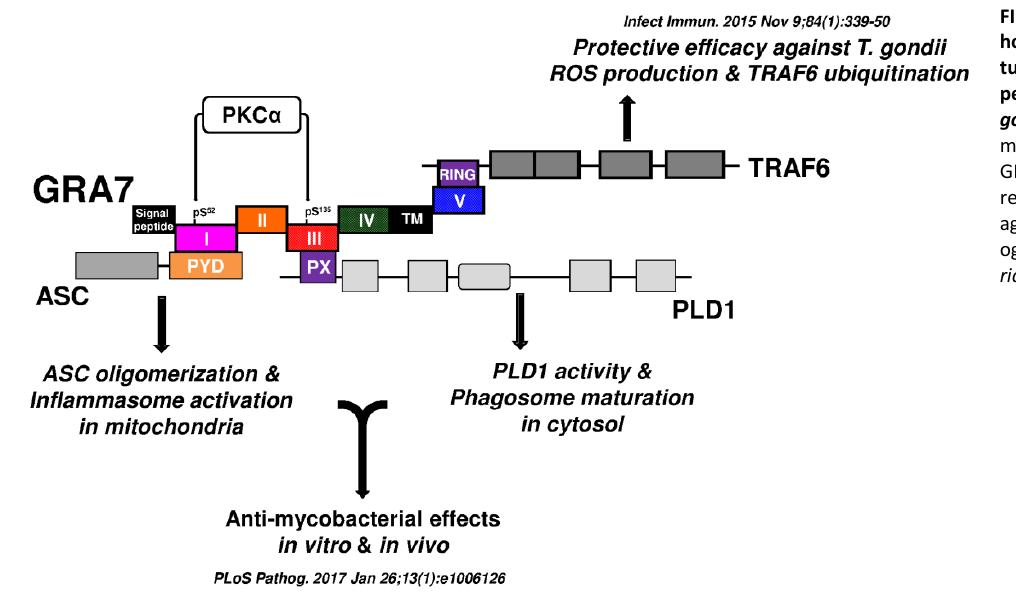
FIGURE 2: Advancing host-directed therapy for tuberculosis: new thera- peutic insights from the T. gondii GRA7. Schematic model for the roles of GRA7 and GRA7-mediated regulatory pathways against intracellular path- ogens such as Mycobacte- ria and T.